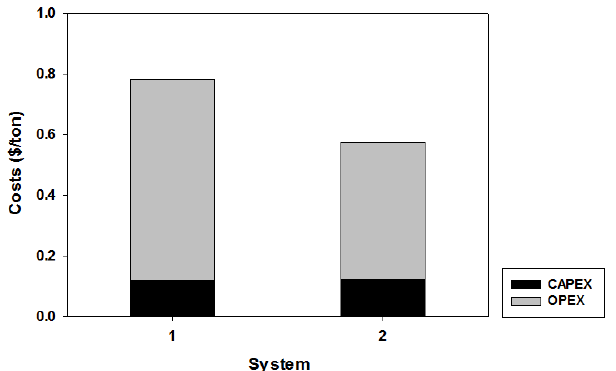
Figure 7. Life-cycle cost of each